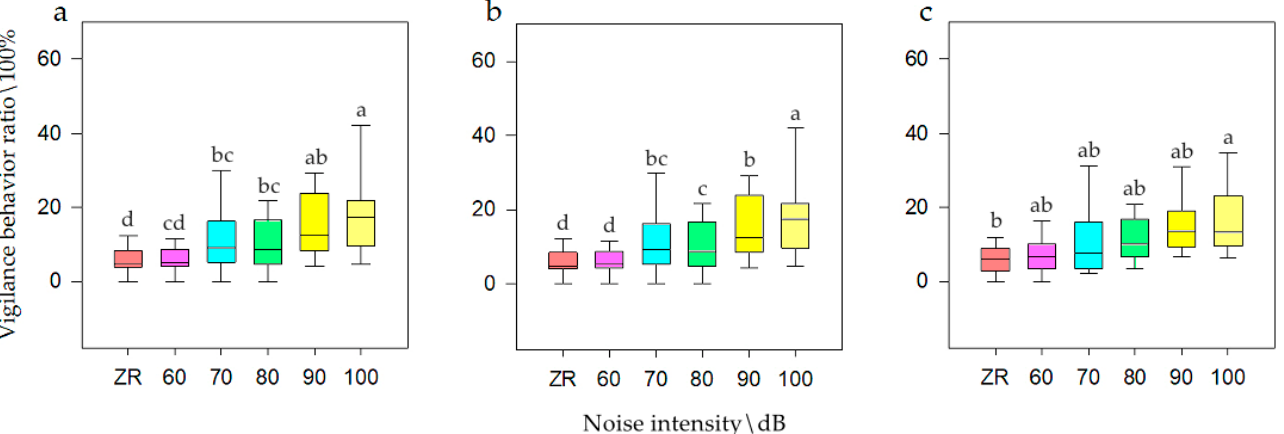
Figure 3. Vigilance behavior of bean geese (( a ) Population N ; ( b ) Population N1 ; ( c ) Population N2 ) of different noise intensity (ZR (background noise), 60, 70, 80, 90, and 100 dB). Different letters in the graphs represent significant differences from one-way ANOVA and SNK tests. Bars represent means; error bars denote standard deviations. The bar with the highest vigilance behavior ratio is marked as “a”. The vigilance behavior ratio is compared with other noise gradients, and the difference is significant, marked as “b” and “c”.